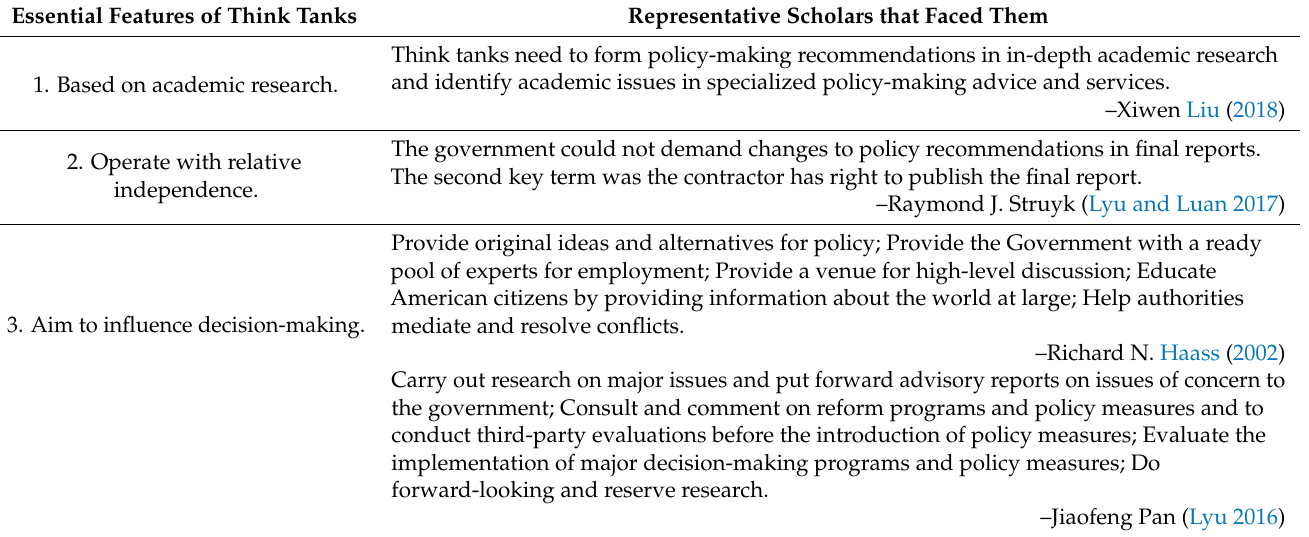
Table 2. The main characteristics of think